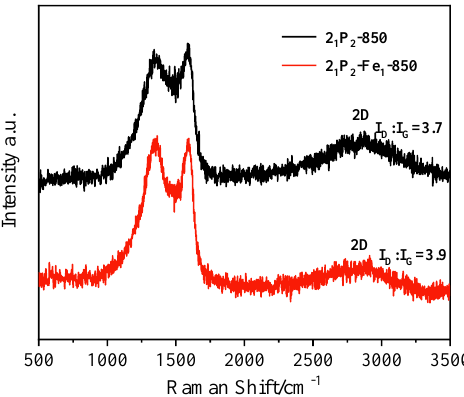
Figure 6. Raman spectra of sample 2 1 P 2 -850 with 2 1 P 2 -Fe 1 -850.